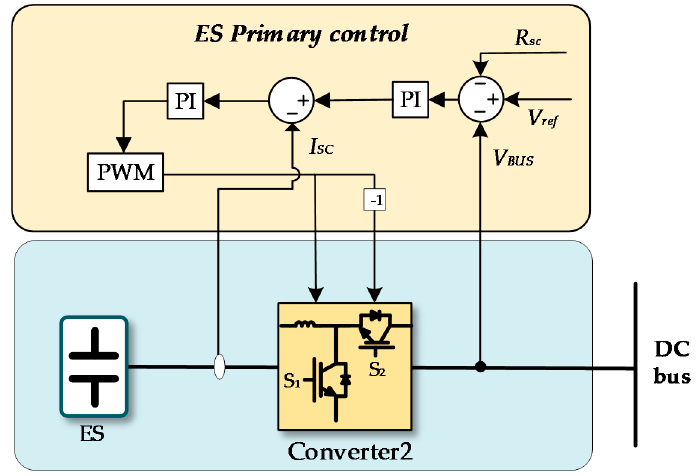
Figure 4. Primary control structure of ES.